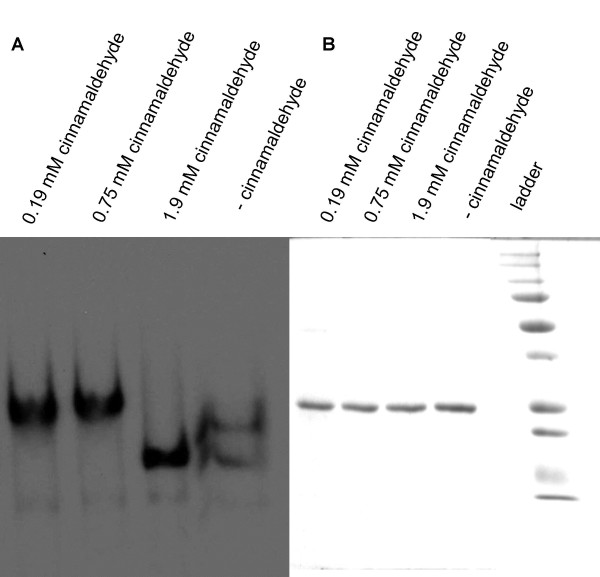
LuxR DNA-binding as determined by mobility shifts and LuxR protein levels as determined by SDS-PAGE. A. Autoradiograph after 5% polacrylamide gel electrophoresis of 32P-labelled LuxR promoter DNA containing the LuxR binding sites, mixed with purified LuxR in the presence (0.19, 0.75 and 1.9 mM) and absence of cinnamaldehyde. B. SDS-PAGE of purified LuxR protein in the presence (0.19, 0.75 and 1.9 mM) or absence of cinnamaldehyde.